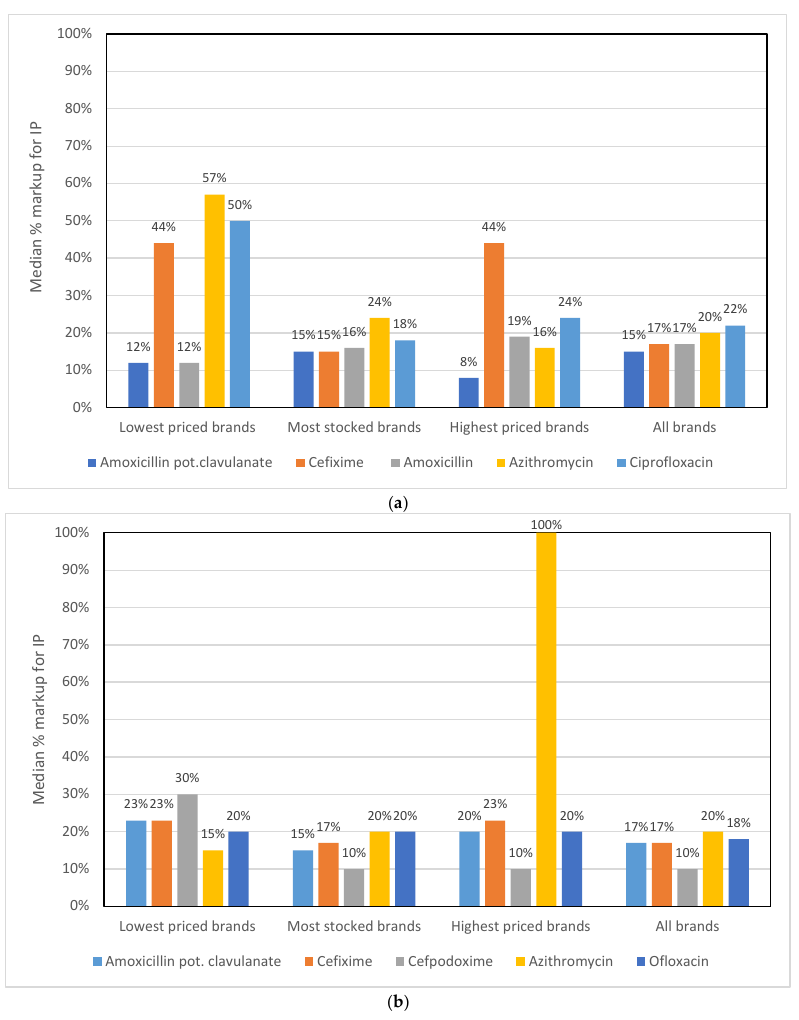
Figure 5. Median percentage markups for IPs for the top 5 antibiotics. ( a ) Tablets ( b ) Syrups/sus- pensions/drops